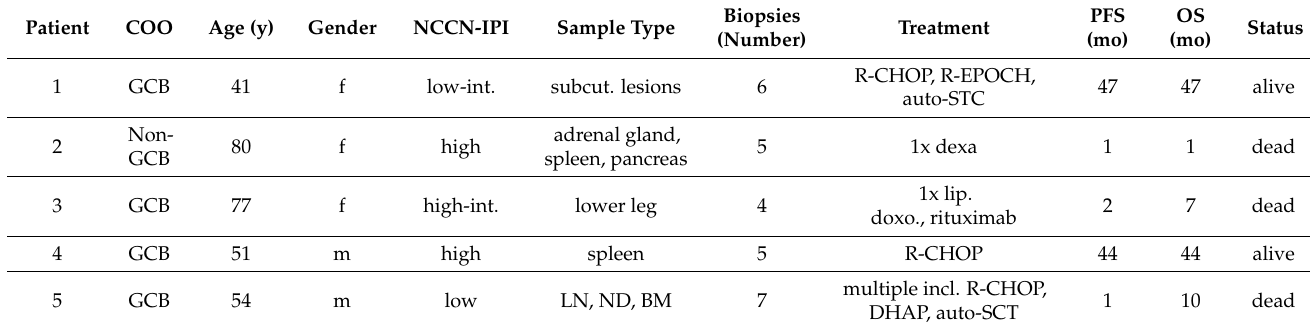
Table 1. Patient